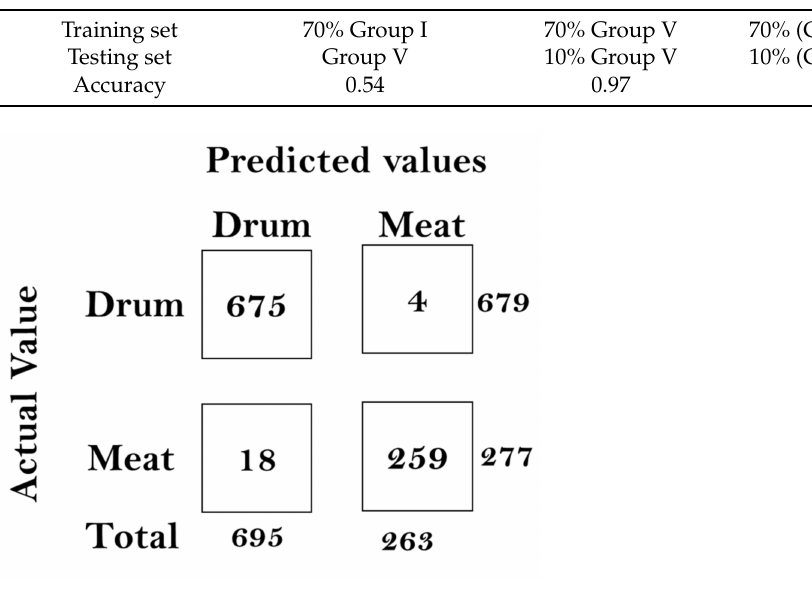
Figure 17. The confusion matrix of Group V.